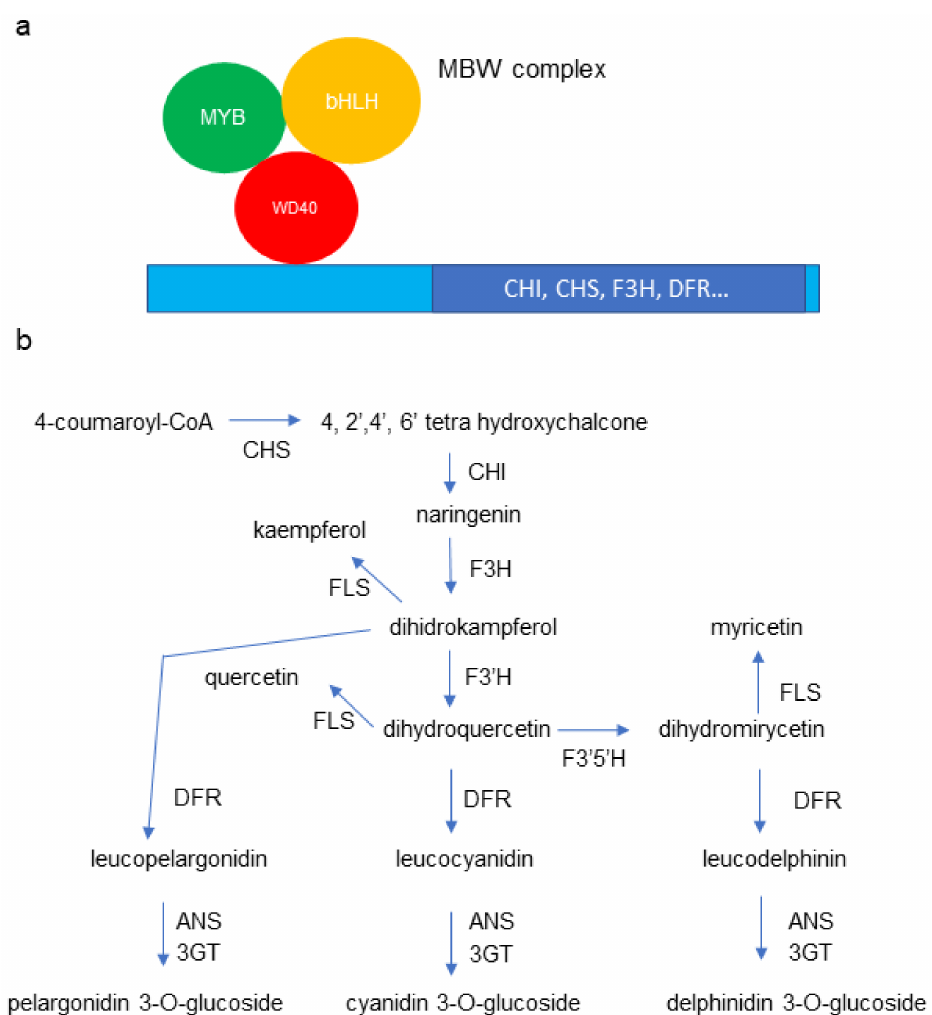
Figure 4. Schematic representation of the anthocyanin pathway. ( a ) Sketch of the MBW an- thocyanin pathway activation complex and ( b ) genes that encode their biosynthesis enzymes; CHS (chalcone synthetase), CHI (chalcone isomerase), FLS (flavonol synthetase), F3H (flavonone 3 (cid:48) -hydroxylase), F3 (cid:48) H (flavonoid 3 (cid:48) -hydroxylase), F3 (cid:48) 5 (cid:48) H (flavonoid 3 (cid:48) 5 (cid:48) hydroxylase), DFR (di- hydroflavonol 4-reductase), ANS (anthocyanidin synthetase), and UFGT or 3GT (UDP-glucose- flavonoid glucosyl